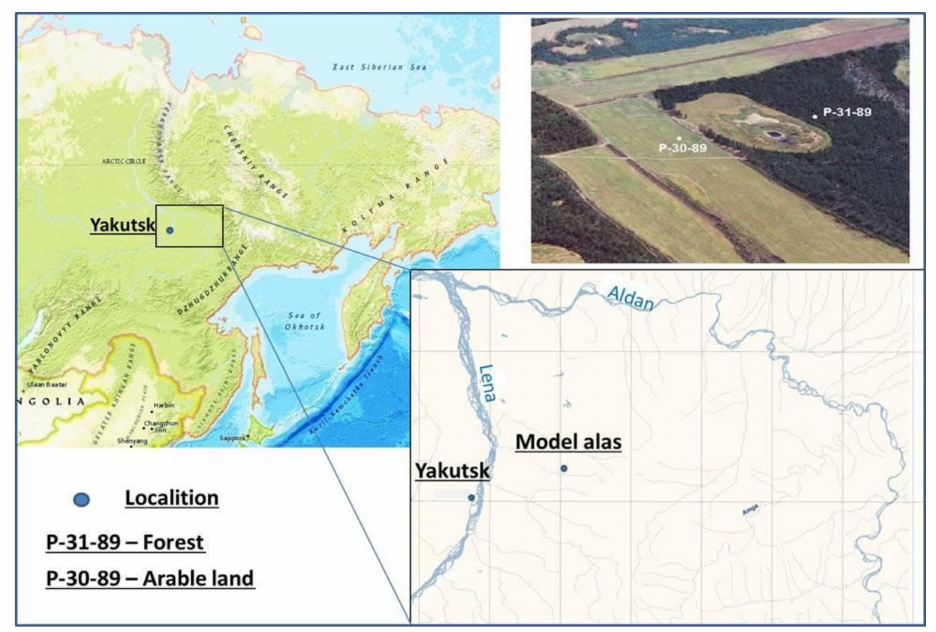
Figure 1. Study area and location of forest (right) and arable land (left)